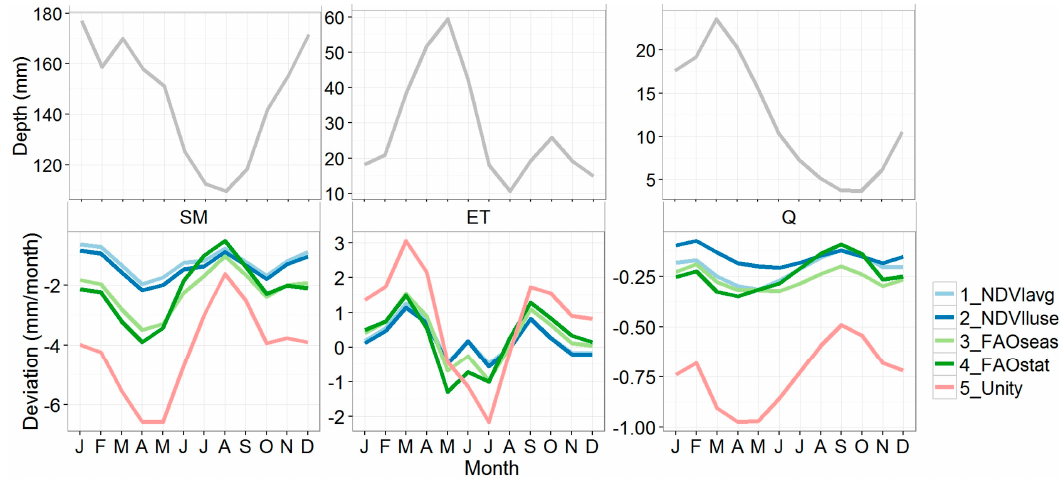
Figure 6 . Average monthly deviation of the five different kc parameterization methods (see Table 1 for explanation), compared to the reference model 0_NDVIref. The upper panels show the absolute mean monthly values for 0_NDVIref for soil moisture (SM), actual evapotranspiration (ET), and streamflow (Q). For SM, this refers to basin-averaged soil moisture content (mm). Negative deviations mean lower values compared to the reference model